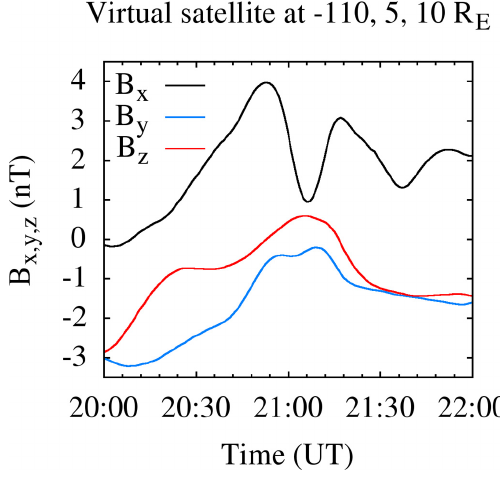
Fig. 7. The magnetic field observed in the simulation by a virtual satellite located at ( − 110, 5, 10) R E in GSE during and after the second AE